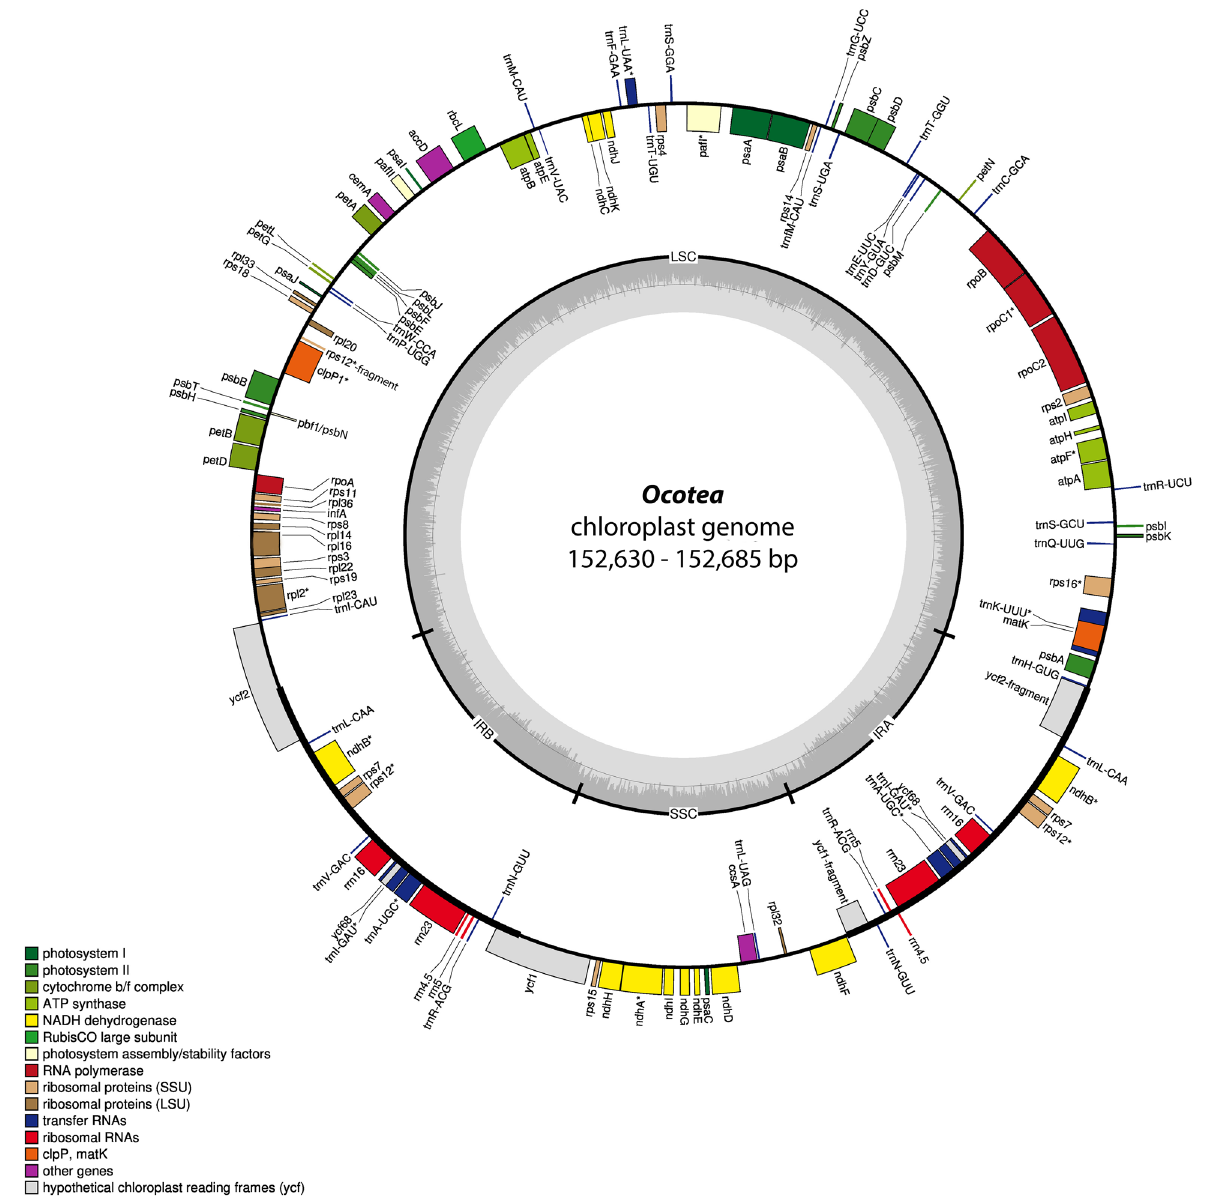
Figure 1. Gene map of Ocotea s pecies ( O. aciphylla , O. daphnifolia , O. foetens , O. guianensis , O. odorifera , O. porosa , and O. tabacifolia ) chloroplast genomes. The genes shown on the inside and the outside of the outer circle are transcribed in clockwise and counterclockwise direction, respectively. The coloured bars denote gene functional groups. The dark gray and light gray shading within the inner circle correspond to percentage GC and AT content, respectively. IR inverted repeat, LSC large single copy, SSC small single